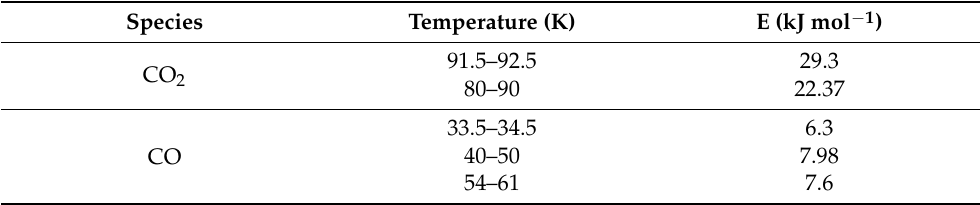
Table 4. Sublimation energy (E) of CO 2 and CO as experimentally measured by Luna et al. [47].